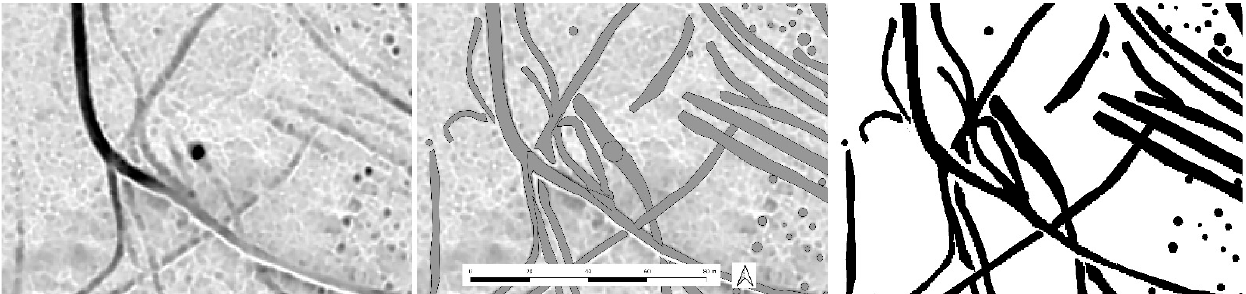
Figure 9. Occlusion of different types of features. A supposed bomb crater located within a hollow way ( left ) is somehow lost within the aggregated vector layer ( centre ) that was later rasterized ( right ).